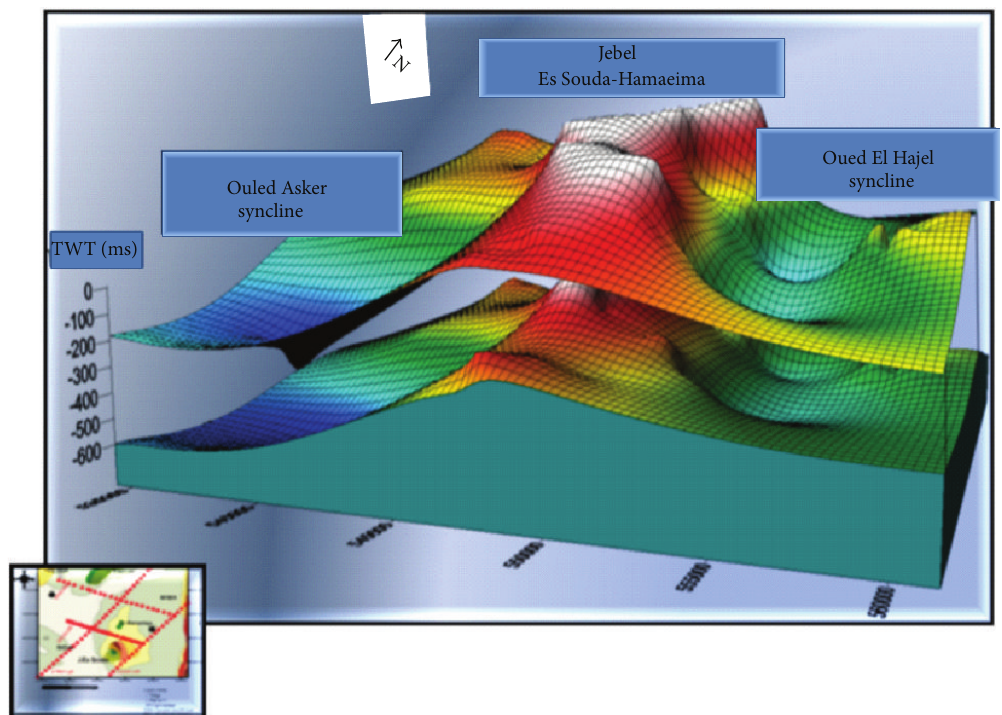
Figure 15: 3D visualization of the Langhian-Serravallian (Middle Miocene) reservoir.